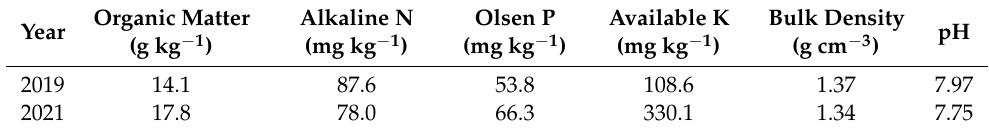
Table 1. Physical and chemical properties of test site soil at a depth of 0–60 cm.